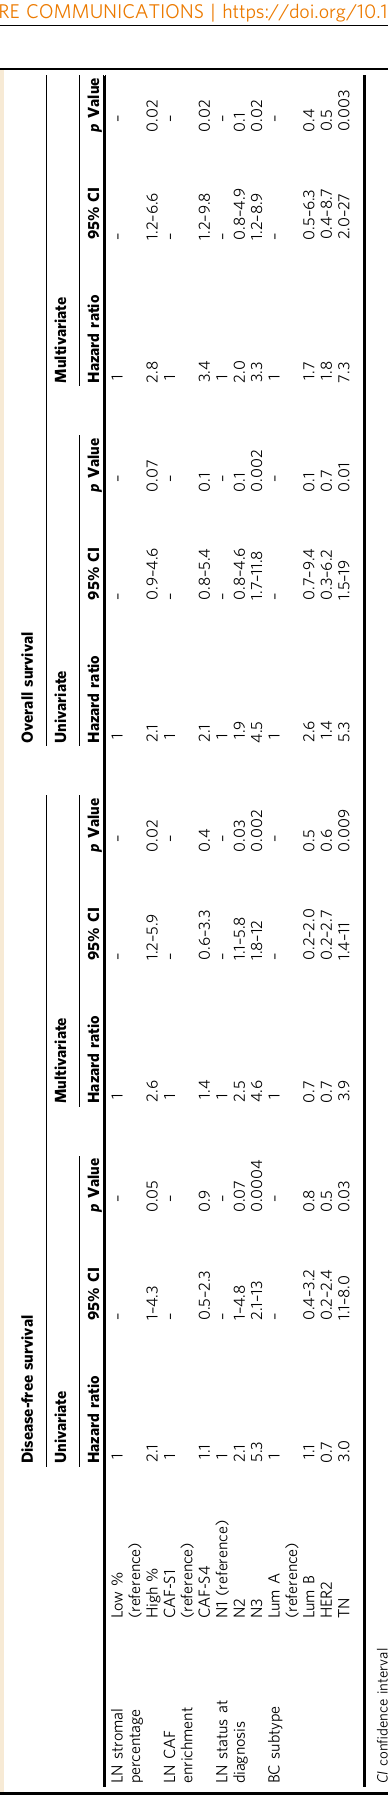
Table 1) were sorted after surface staining (see ‘ Flow Cytometry on BC PT and LN samples') on FACSARIA (BD biosciences), directly into RNase-free tubes